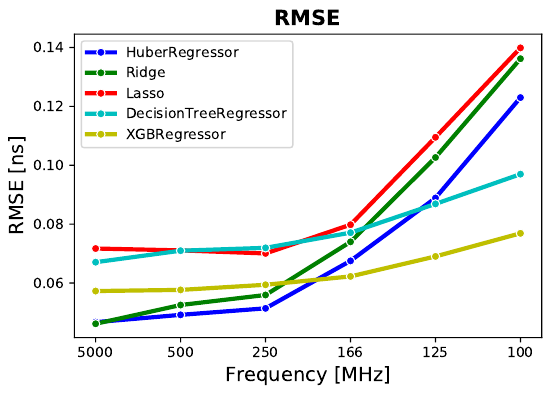
Figure 4. Models comparison for time di ff erence RMSE (ns) w.r.t. sampling frequency